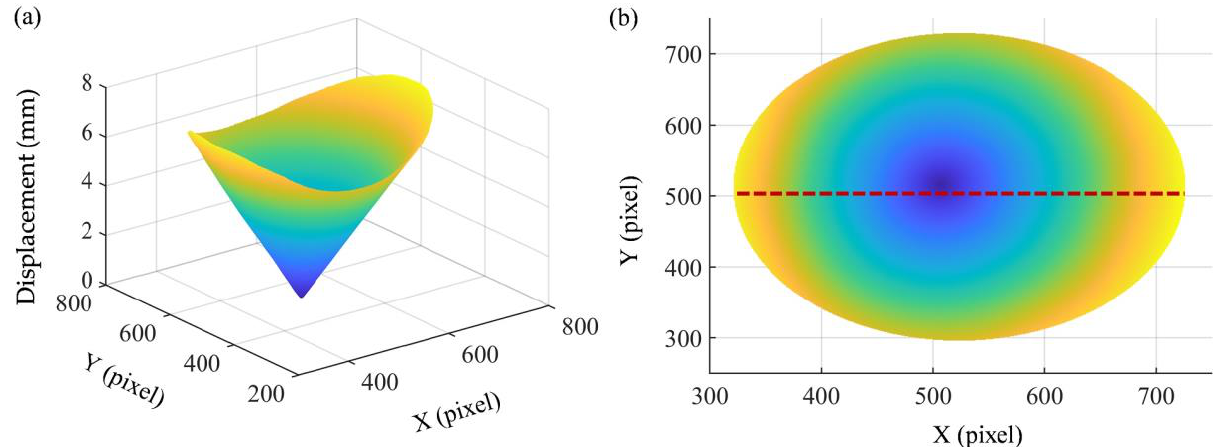
Figure 8. The total displacement. ( a ) The stereogram of the full-field displacement; ( b ) the planar graph of the full-field displacement.